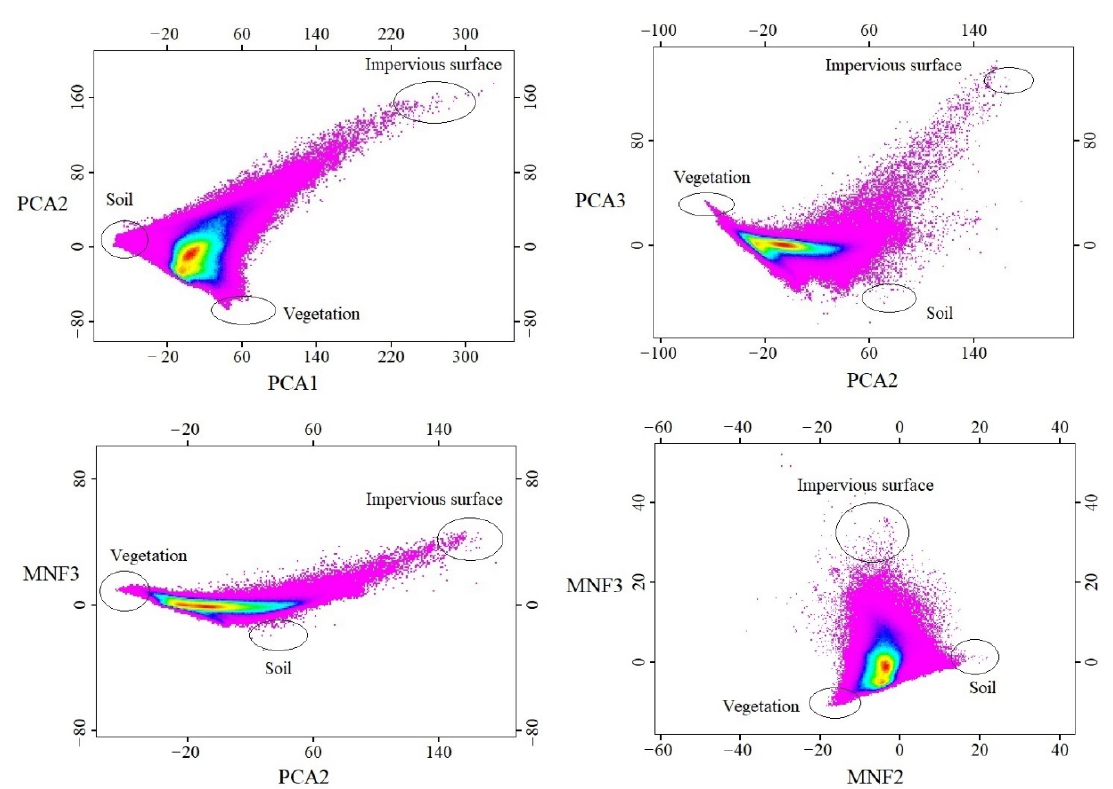
Figure 5. 2-D scatter plots generated from the first three components of each of the statistical analysis methods, PCA and MNF.